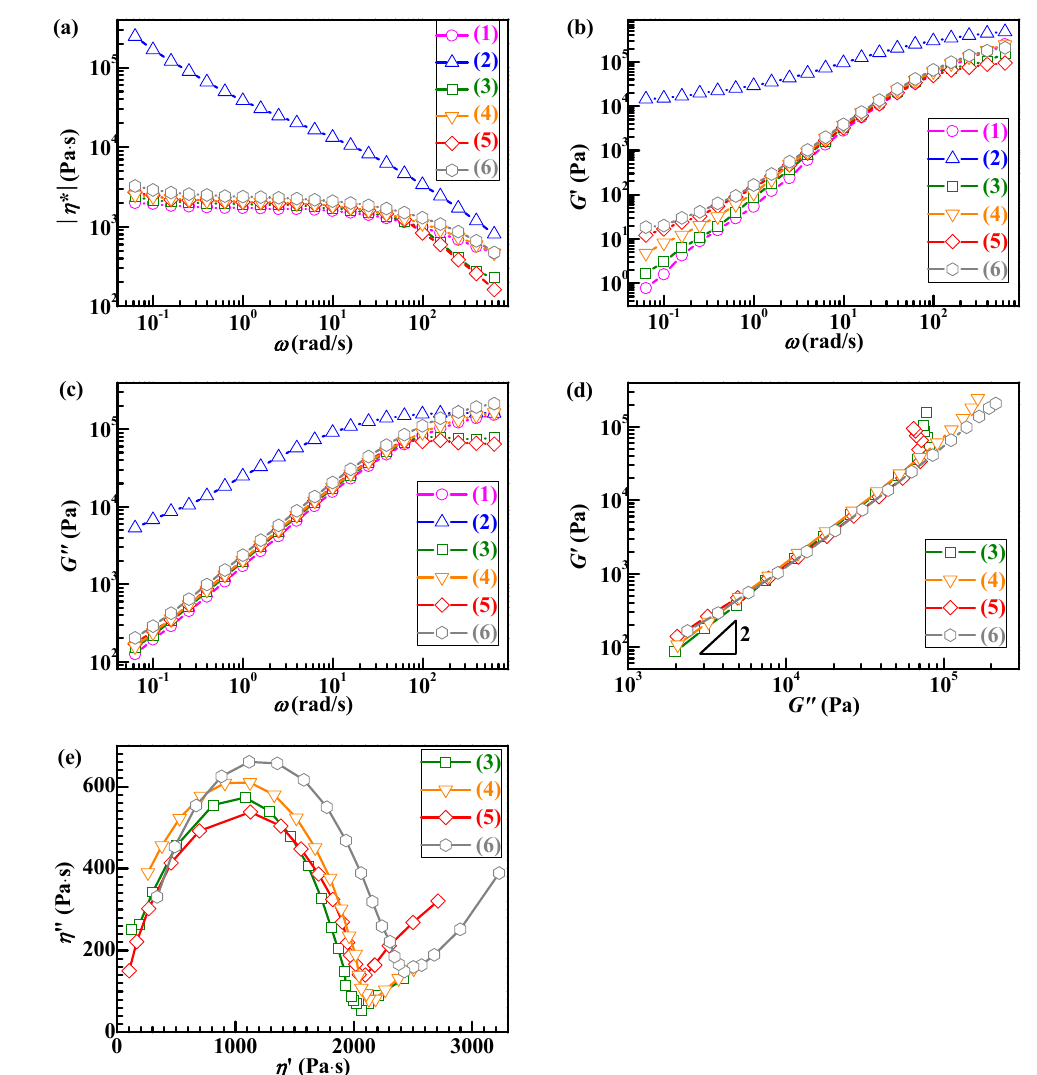
Figure 5. ( a ) Complex viscosity magnitude ( | η * | ), ( b ) dynamic storage modulus ( G (cid:48) ), and ( c ) dynamic loss modulus ( G ”) as functions of angular frequency ( ω ), (i.e., log | η * | vs log ω , log G (cid:48) vs log ω , and log G ” vs log ω , respectively), ( d ) Han (i.e., log G (cid:48) vs log G ”) plots, and ( e ) Cole–Cole (i.e., η ” vs η (cid:48) ) plots, which were obtained from the frequency-sweep tests at 180 ◦ C in the oscillatory shear mode, for (1) (neat) PLA, (2) (neat) SBS, blends of PLA and SBS (95 / 5 w / w) (3) uncompatibilized and (4) compatibilized with 1.0 wt % of S-MA, and blends of PLA and SBS (90 / 10 w / w) (5) uncompatibilized and (6) compatibilized with 1.0 wt % of